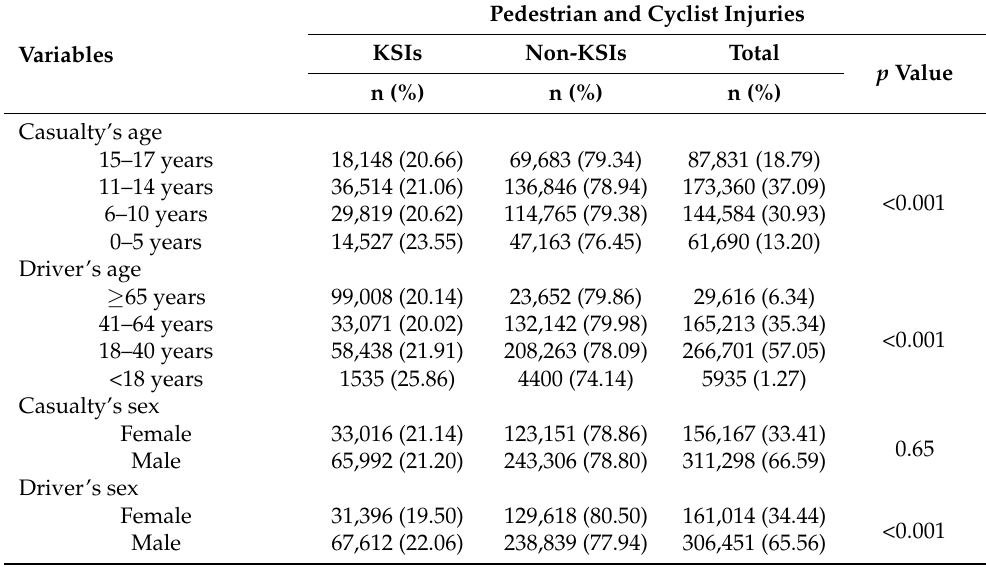
Table 1. Distribution of study participant’s characteristics based on injury status.